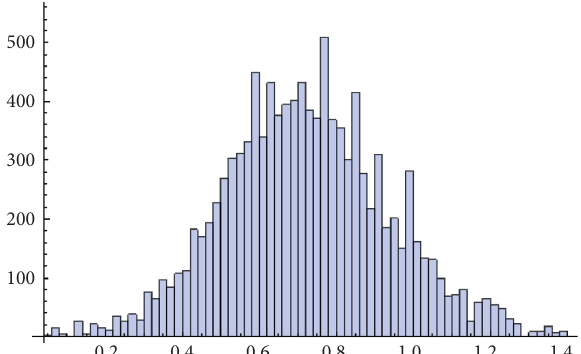
Figure 2: The histogram of α generated by the MCMC method.